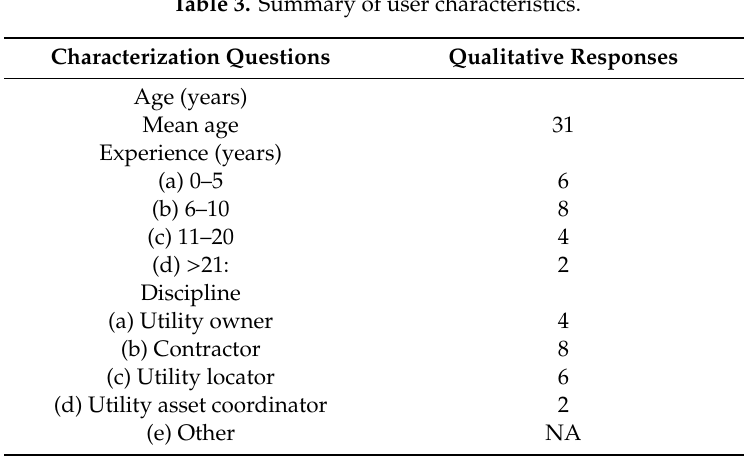
Table 3. Summary of user